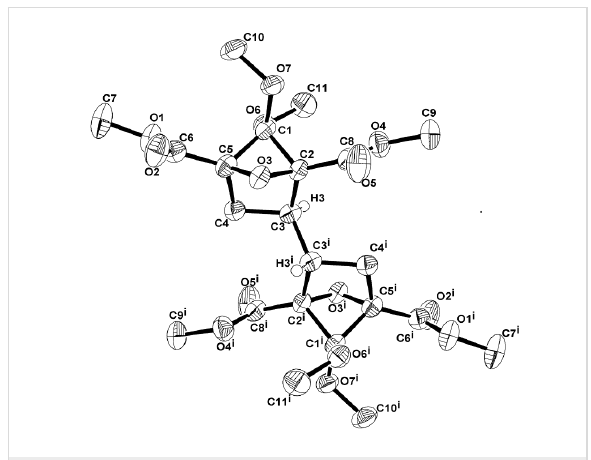
Figure 1: ORTEP structure of 8 [50% probability thermal ellipsoids; some of the hydrogen atoms and a solvent molecule (acetonitrile) are omitted for